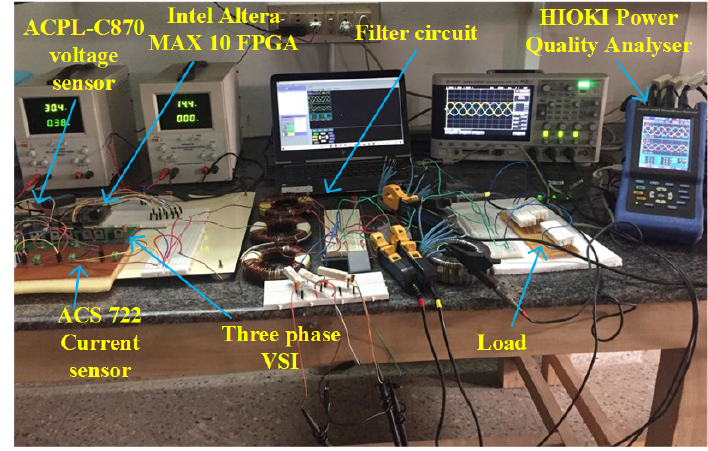
Figure 24. The complete experimental setup.